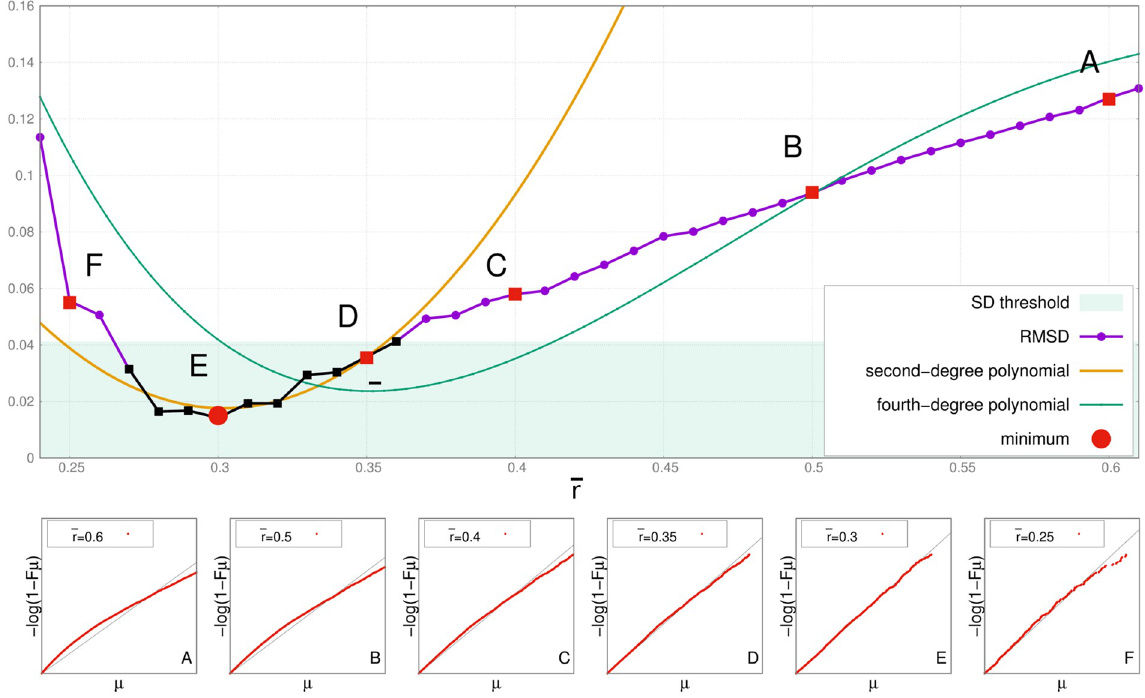
Fig 1. Technical procedure to locate the threshold value minimizing the RMSD. Upper Panel: RMSD of the sets S The minimum of the RMSD is obtained for � r ¼ 0 : 3 (point E). In green we show the four-degree polynomial fitting the RMSD, with standard deviation SD. The RMSD values falling below the minimum of such polynomial plus SD (green area) are plausible RMSD minima (highlighted in black). We fit these plausible RMSD minima by a second-degree polynomial (yellow curve). The argument of the minimum of such polynomial is considered as the putative value minimizing the RMSD. Panel A: sets S as A for � r ¼ 0 : 4 . Panel D: same as A for � r ¼ 0 : 35 . Panel E: same as A for � r ¼ 0 : 3 . Panel F: same as A for � r ¼ 0 : 25 . The S straight line, while the others show a